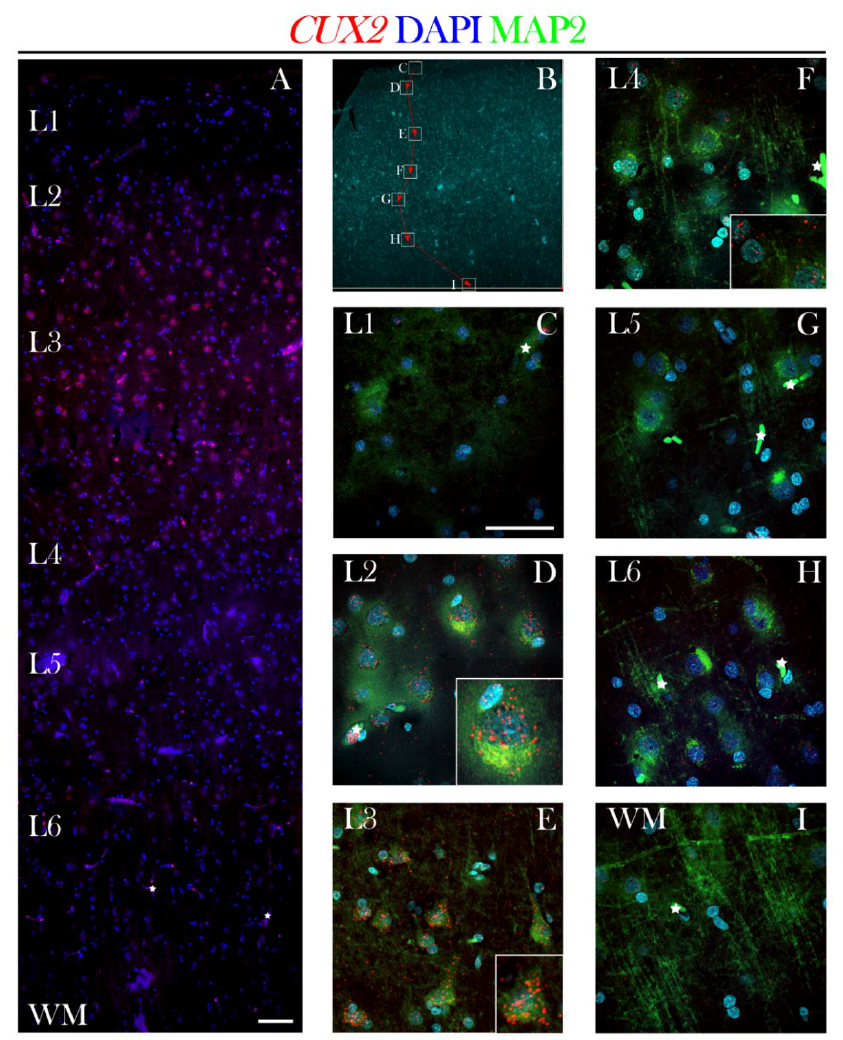
Figure 11. CUX2 mRNA is expressed in upper layers of adult PFC (18 y). ( A ) CUX2 mRNA (red) expression in adult PFC in upper layers of the post-SP phase was detected using the fluorescent in situ hybridization using RNAScope ® . ( B ) Overview image of PFC (Brodmann area 9) stained with DAPI. Boxes show respective locations of representative high magnification confocal images taken in C–I. ( C–I ) Single CUX2 mRNA particles in red are visible in each of the upper cortical layers (L1-4) co-stained with MAP2 (green) and DAPI (blue). White stars depict blood vessels oversaturated with signal. Scale bar A = 200 µm, and C–I = 50 µm.